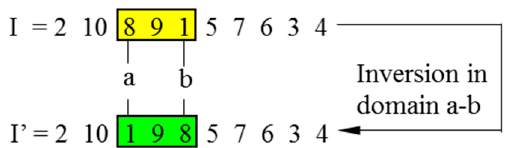
Figure 4. Single-domain inversion.